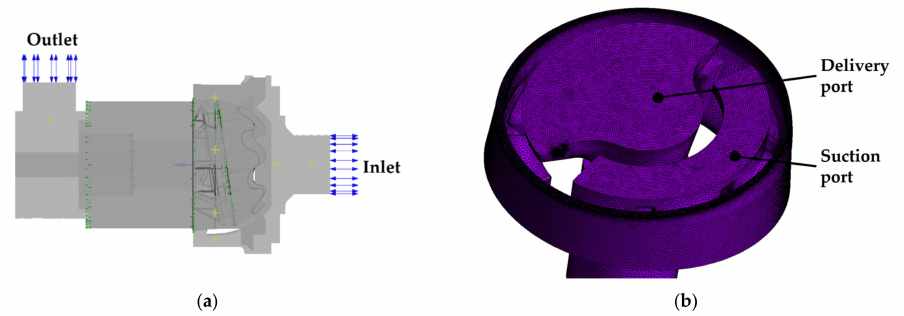
Figure 10. Full CFD model with BCs ( a ) and meshing details of the fluid volumes in the hollow shaft ( b ) of the TMC